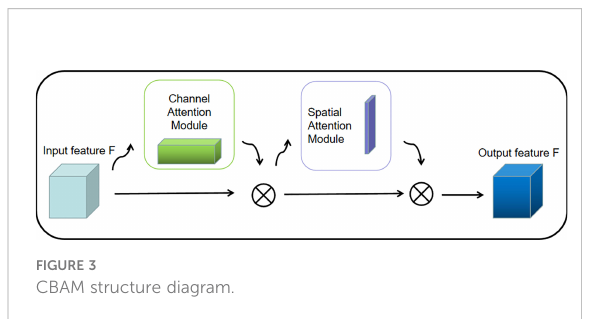
FIGURE 5 Spatial attention mechanism.